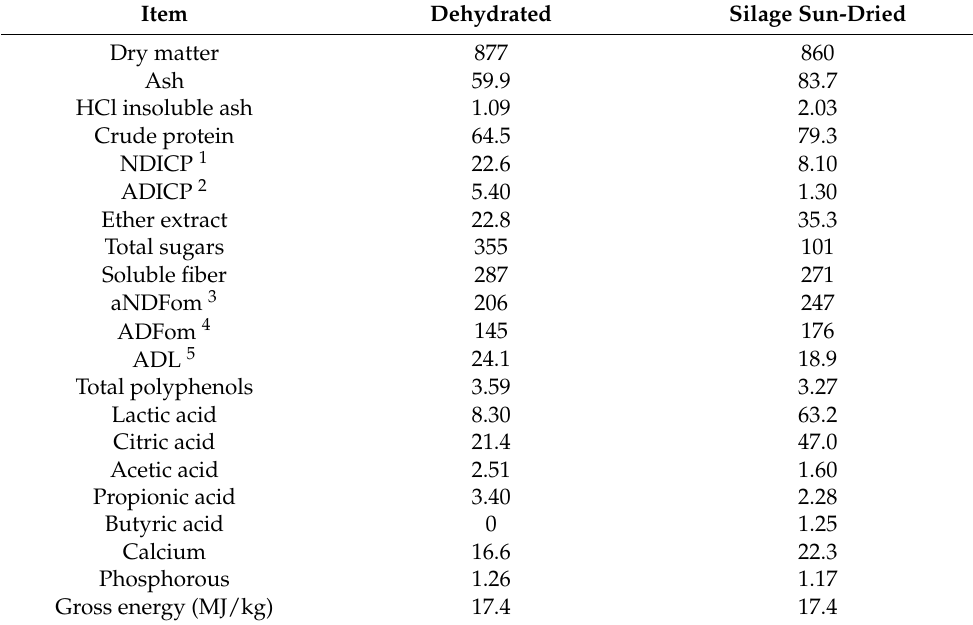
Table 1. Analyzed nutrient composition of the two sources of orange pulp used in the present study (g/kg, dry matter